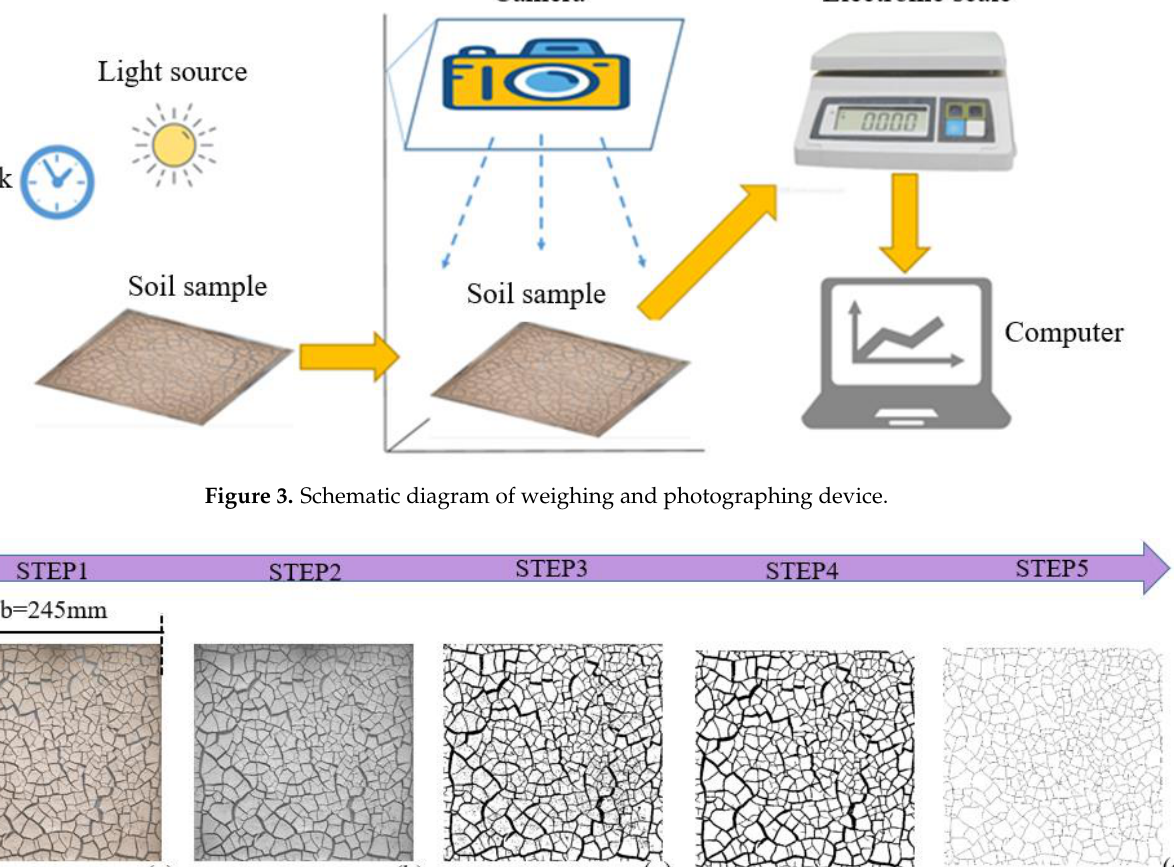
Figure 3. Schematic diagram of weighing and photographing device.